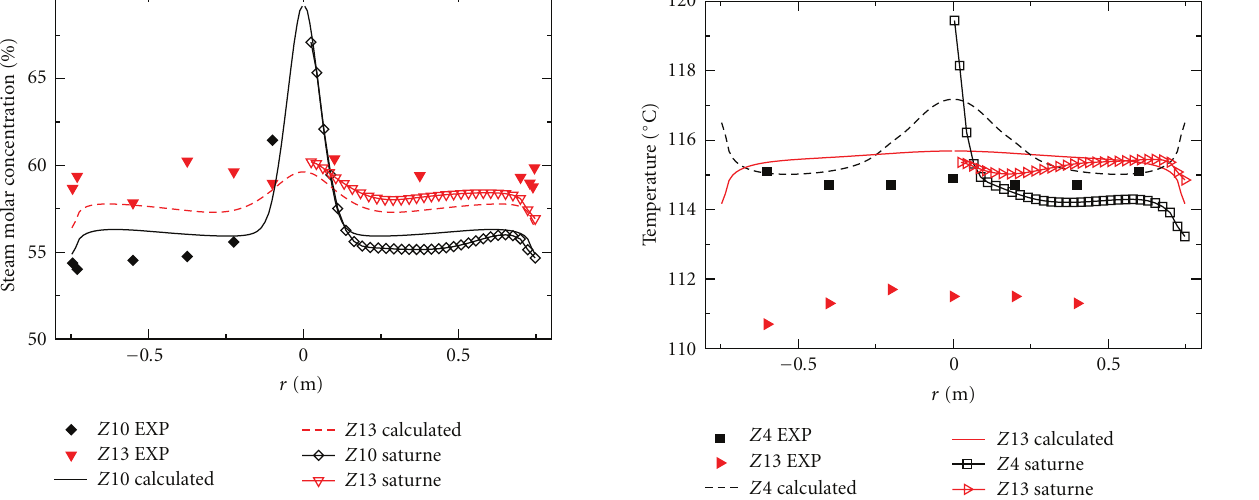
Figure 14: Radial profile of the gas temperature at Z 4 = 1 . 47 m and Z 13 = 3 . 93 m: steady state